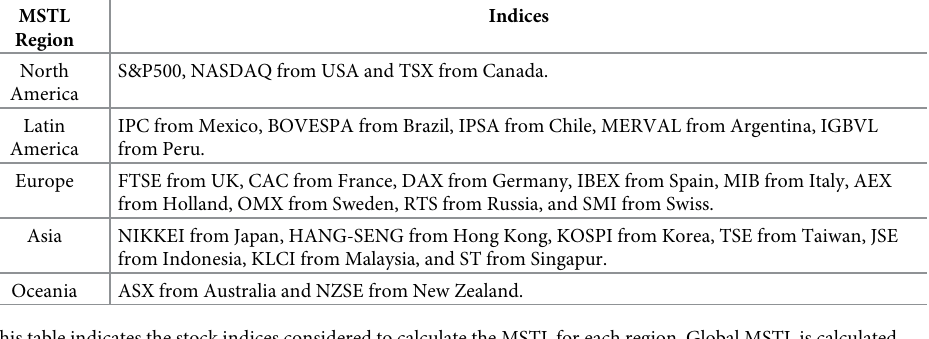
Table 1. Stock country indices to estimate MSTL’s region.